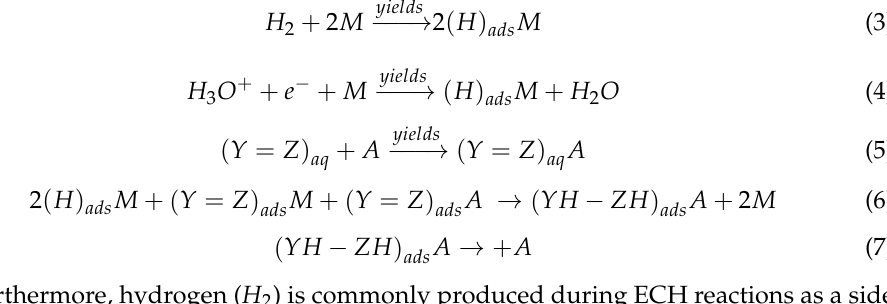
of FF depends on the reduction of hydronium ions to produce atomic hydrogen using